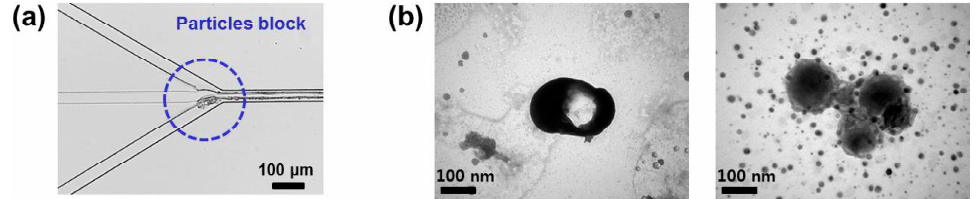
Figure 3. Problem of the flow-focusing synthesis: ( a ) aggregation and clogging of the protein nanoparticles at the junction of inlet channels and along the channel; ( b ) transmission electron microscopy (TEM) images of the aggregated particles.